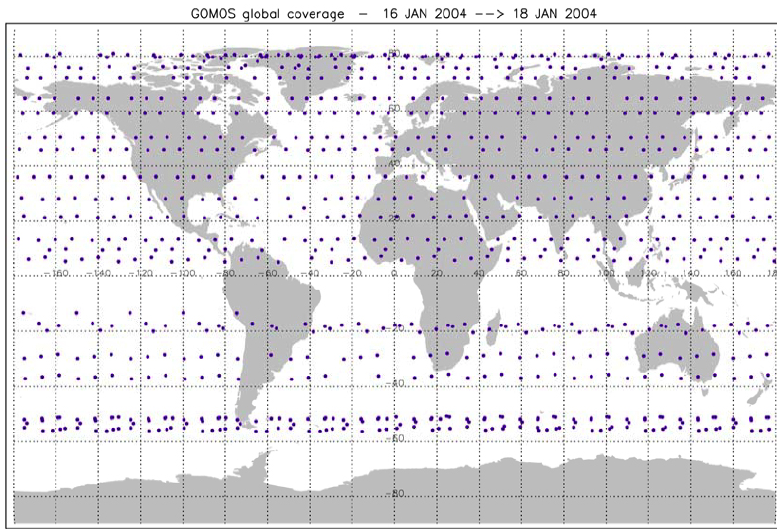
Fig. 8. Each point represents the location of one occultation, performed during a period of 3days (16–18 January 2004). The pattern is regular in longitude, but irregular in latitude, since it depends on the availability of stars. Because of the geometry of occultation, one measurement is a horizontal average over a few hundred km, which adds somewhat to the